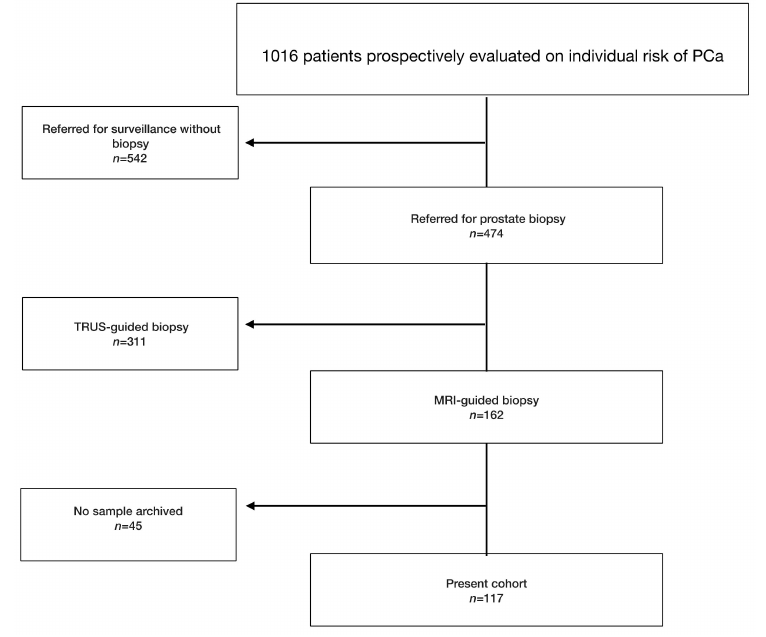
Figure 1. Flowchart presenting the selected study population. PCa: prostate